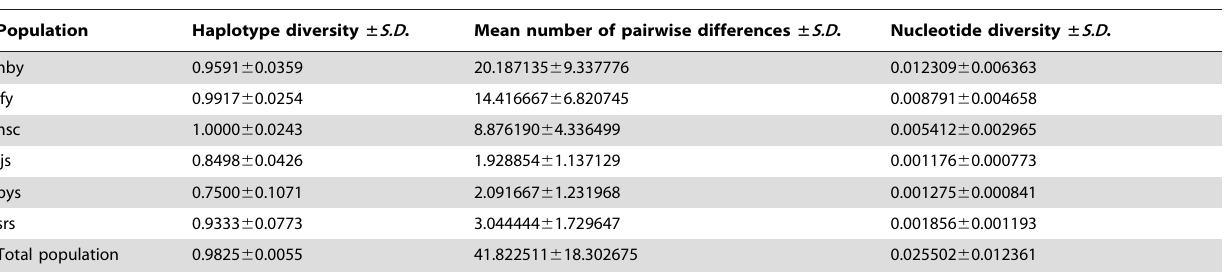
Table 2. Genetic diversity of each population of S. ningshanensis .